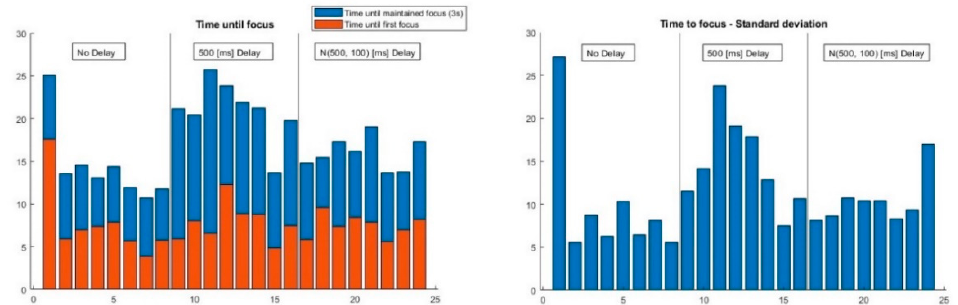
9, right) values of the TTF corresponding to all eight trajectories of the moving element,